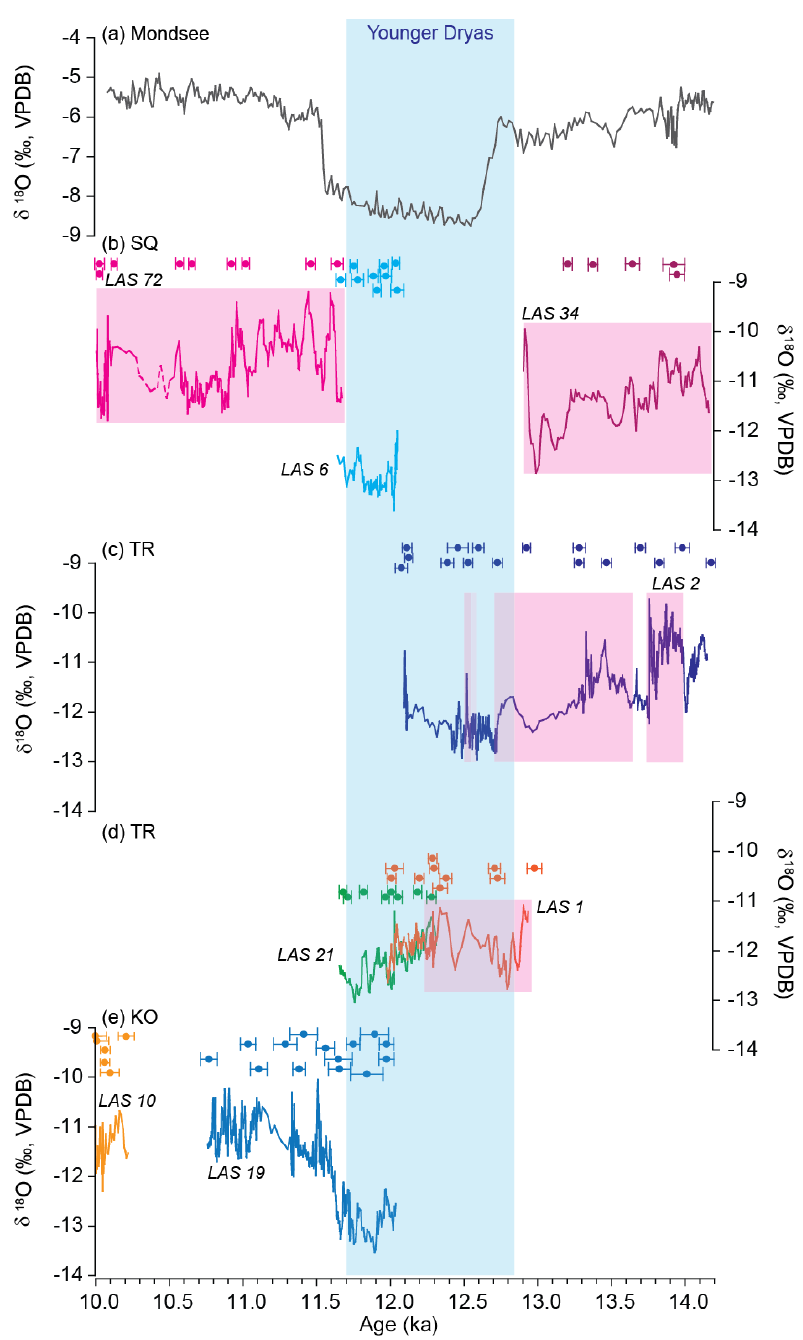
Figure 6. Comparison of δ 18 O time series of (a) benthic ostracods from Mondsee (Lauterbach et al., 2011) and the Vinschgau flowstones (b– e) . (b) shows the three samples from SQ site: LAS 72 (bright pink), LAS 6 (turquoise) and LAS 34 (dark pink). The δ 18 O variability of the TR samples is shown in (c) and (d) , where dark blue represents LAS 2, green and orange mark the oxygen isotope record of LAS 21 and LAS 1 respectively. LAS 10 (yellow) and LAS 19 (light blue) from KO are shown in (e) . Note that the pink rectangles are indicative of aragonite and the blue bar refers to the Younger